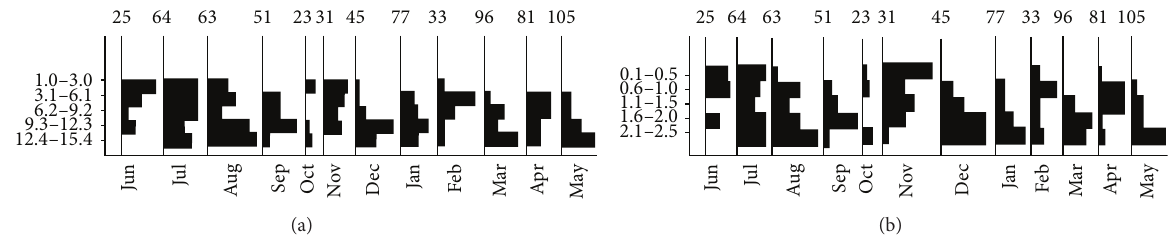
Figure 5: Size frequency distribution of (a) body length (mm) and (b) head width (mm) of N. biseriata .